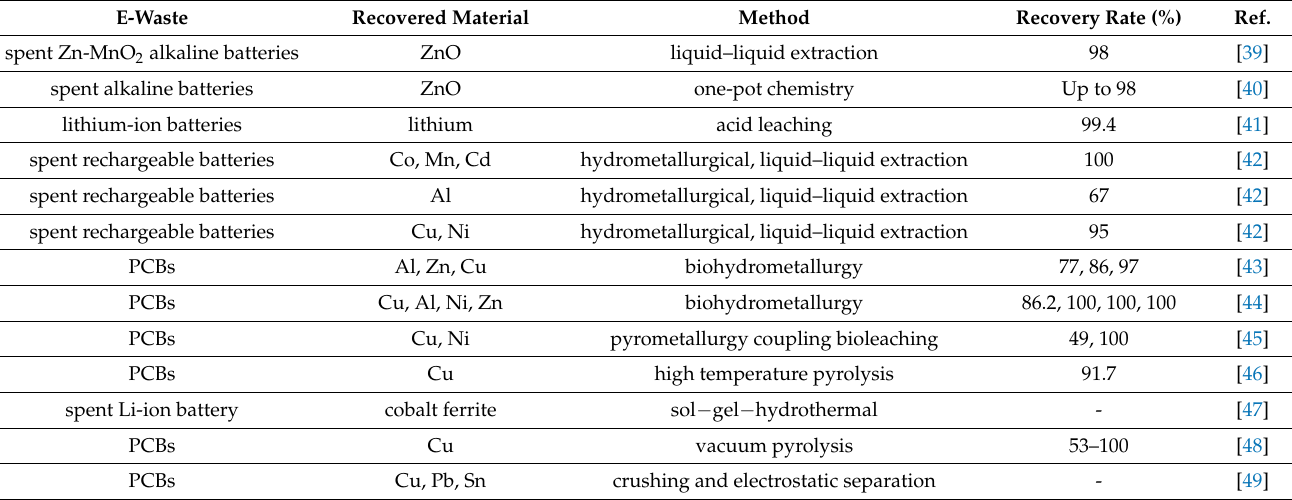
Table 1. Different recovered materials from e-wastes by the utilization of various methods and their efficiency.